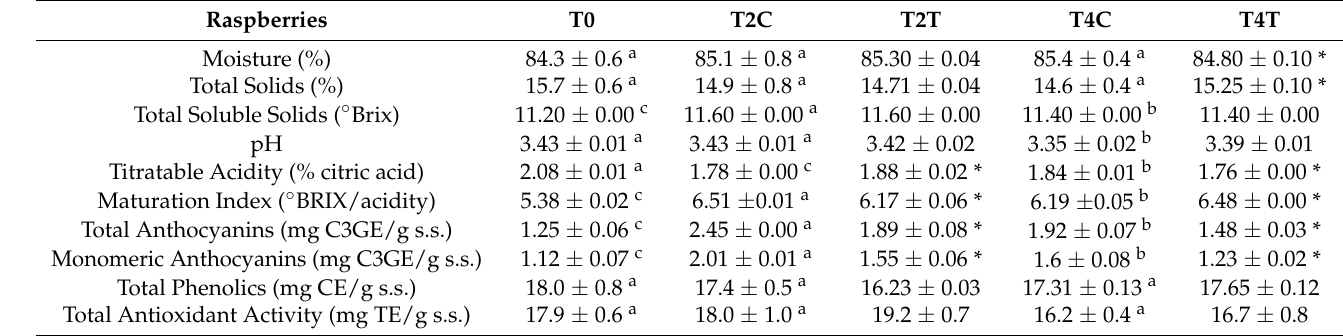
Table 6. Chemical parameters quantified in the raspberries, during the four days of storage (C= filter paper covered with 10% DMSO in PBS solution as control sample, T = filter paper covered with 10% ( v / v ) cinnamon oil). Different letters represent significant differences within each row ( p < 0.05) between the control samples. * indicates a significant difference between treated and control sample at the same